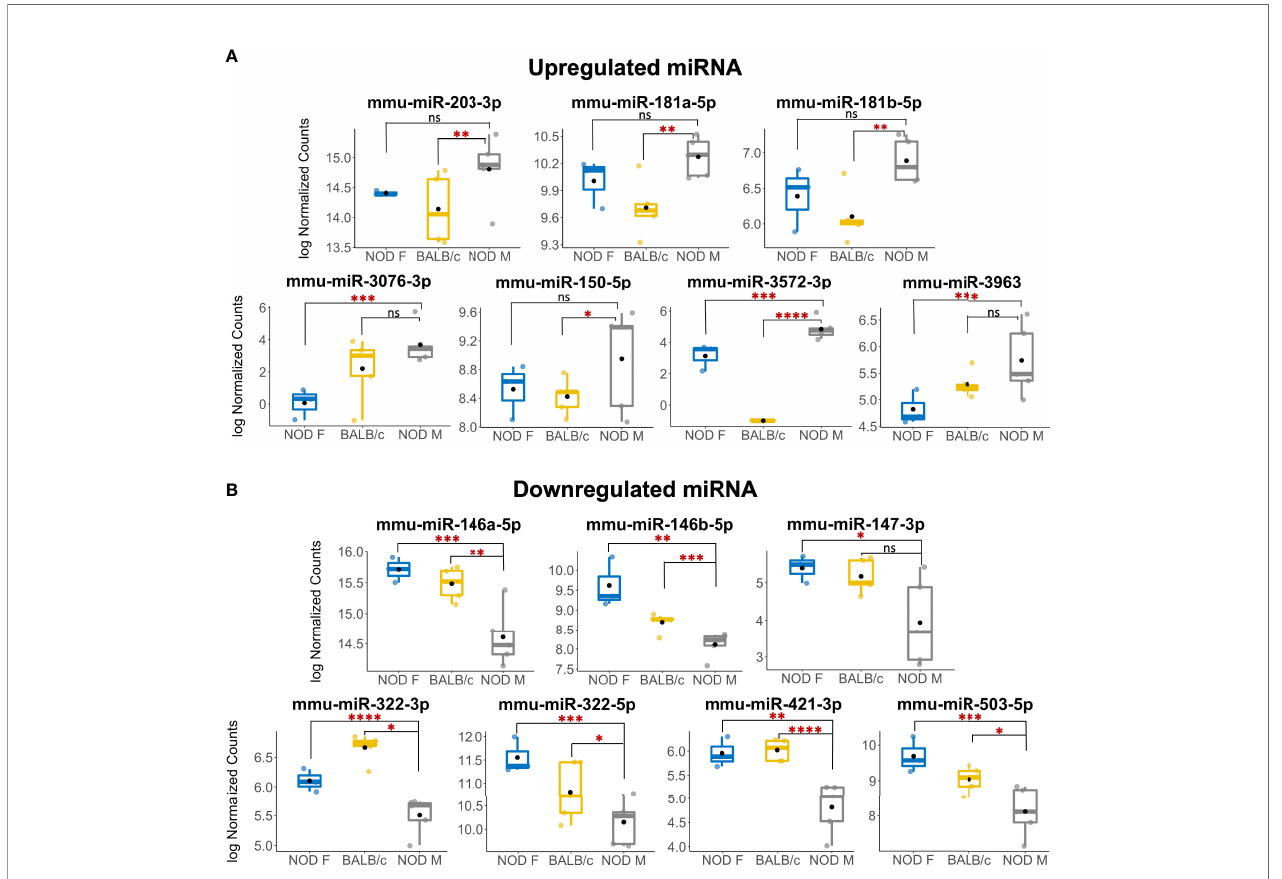
FIGURE 4 | Multiple miRNAs are differentially expressed in tears of diseased male NOD mice. (A) 7 miRNAs were identi fi ed as upregulated in tears of 12-14 week male NOD mice while (B) 7 more miRNAs were found to be downregulated in tears of 12-14 week male NOD mice as compared to both age-matched female NOD and male BALB/c mice. Log10 Normalized miRNA counts as calculated by DESeq2 are plotted for each strain. N=5 samples for male NOD and BALB/c, and N=3 samples for female NOD mice; n=5 mice per sample for each strain. miRNA were considered differentially expressed if the fold change trended in the same direction for NOD M vs BALB/c and NOD M vs NOD F; had a mean expression value of 10 reads or higher and had a signi fi cant unadjusted p value in at least one of the two comparisons. (*p < 0.05; **p < 0.01, ***p < 0.001, ****p < 0.0001, DESeq2; ns, not signi fi